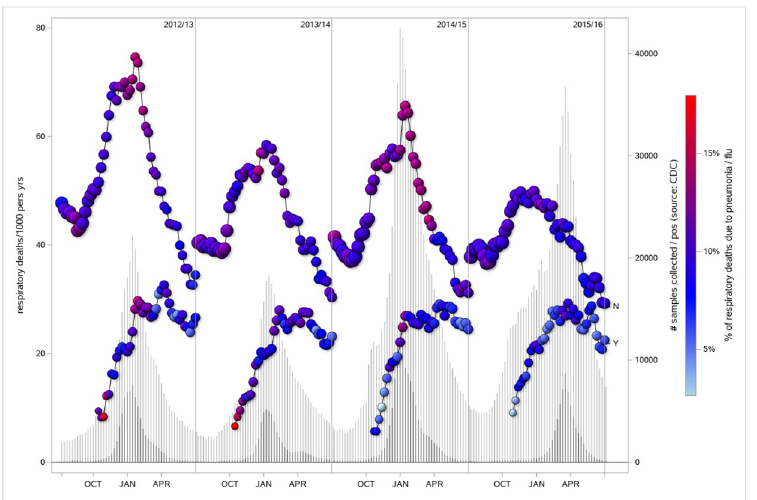
Fig 1. Respiratory mortality in vaccinated vs. non-vaccinated veterans with COPD and corresponding background viral activity, by influenza season, 2012–13 through 2015–16. � Mortality rates are calculated as a 3-week moving average. They are represented on the left-hand y-axis in respiratory-related deaths per 1000 person- years. Bubbles on upper and lower lines are sized according to number of people at risk in each week for non- vaccinated (line ending with ‘N’) and vaccinated (line ending with ‘Y’), respectively. Bubble color ranges from light blue ( < 5%) to red ( > 15%) and reflects the percent of respiratory deaths for the week attributable specifically to pneumonia or influenza. Mortality rates for the vaccinated population are unstable during the early season due to small counts of vaccinated individuals; therefore, rates are suppressed until 20% of the overall population is vaccinated in each season. Vertical ‘needles’ are scaled according to the right-hand y-axis and show total weekly influenza samples collected in the United States by the Centers for Disease Control and Prevention (light gray) and total number of those which tested positive (dark